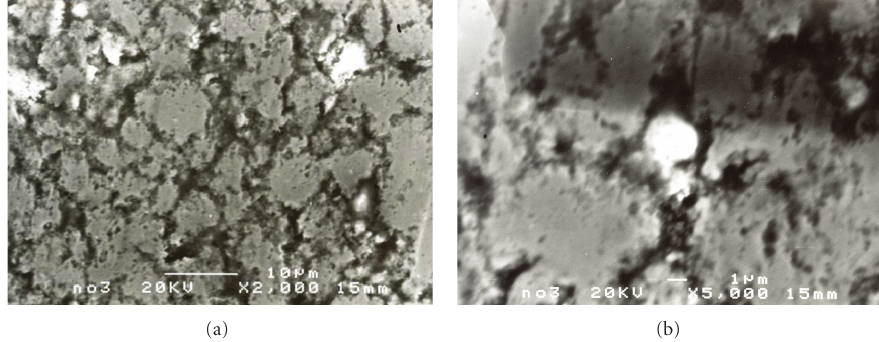
Figure 5: Micrographs of a sintered 20wt.% ceramic content nickel-alumina composite, at two